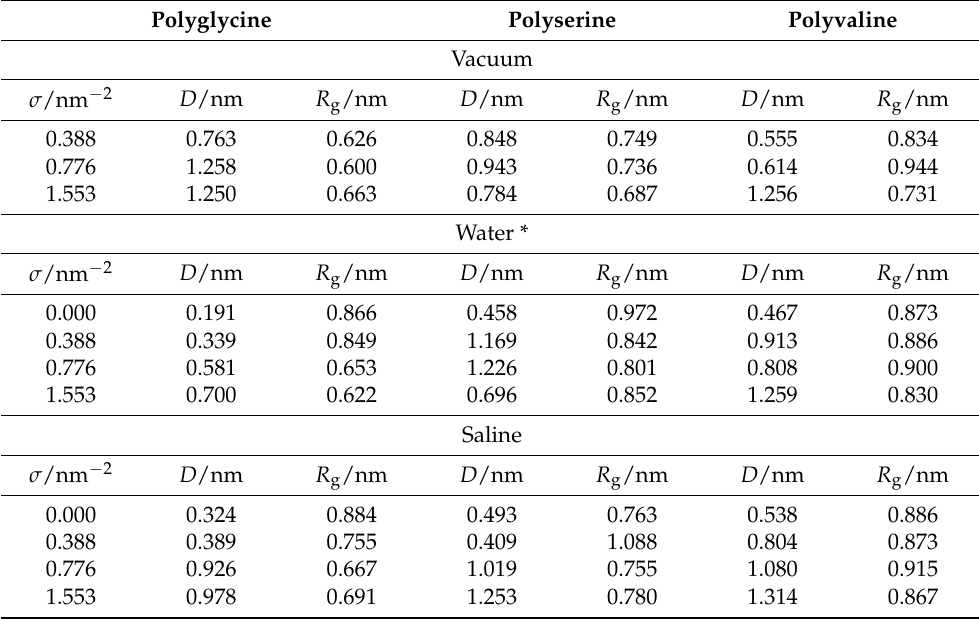
Table 1. Distance of the center of mass of the peptides from the CNT sidewall, D , grafted with the PEO chains at different grafting densities, σ , and the radius of gyration, R g , in a vacuum, water, and